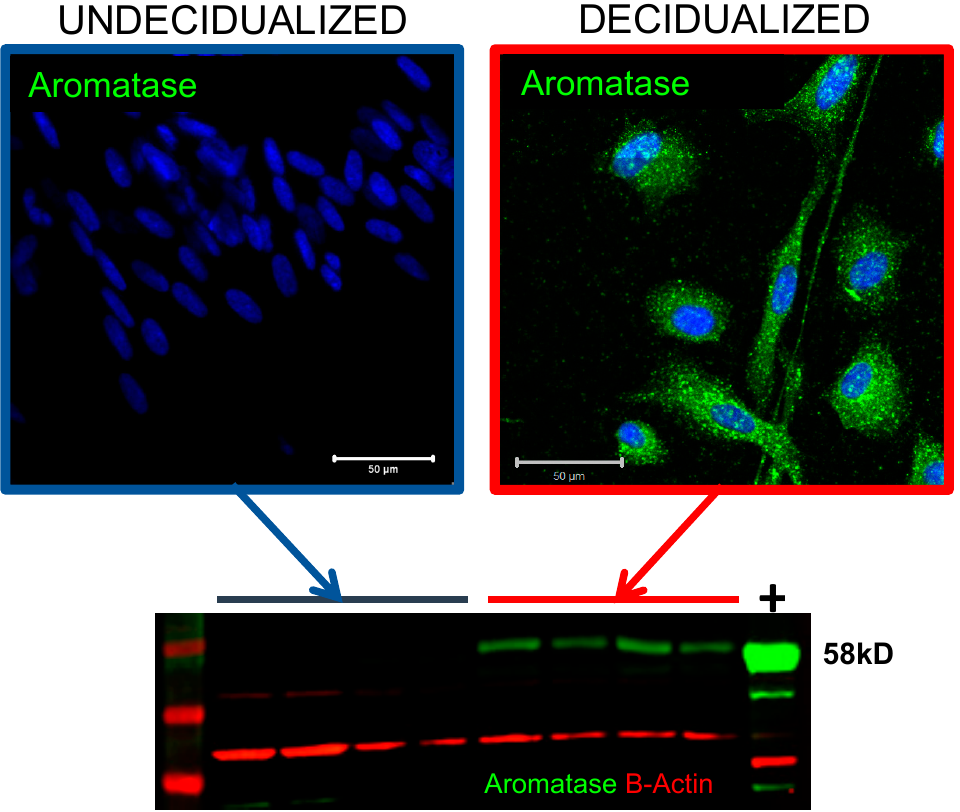
Figure 3. In vitro decidualisation of endometrial stromal fibroblasts results in upregulation of aromatase protein expression (green). Based on data reported in [13]. ESC—primary endometrial stromal fibroblasts; positive control (+) was a protein extract from human placenta, aromatase protein 58kDa. Nuclear counterstain DAPI (blue); Aromatase (green); B-Actin loading control (red).